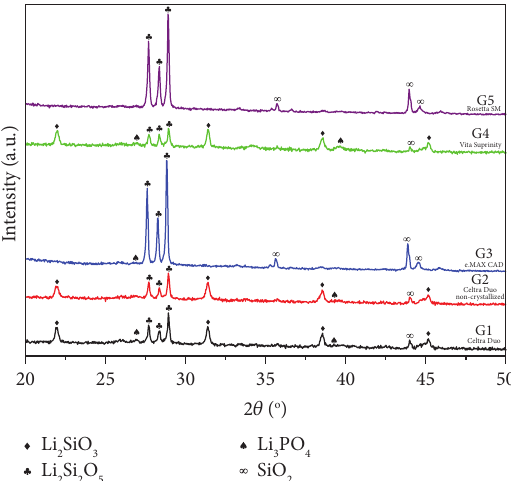
Figure 2: X-ray diffraction patterns of glass-ceramics from different